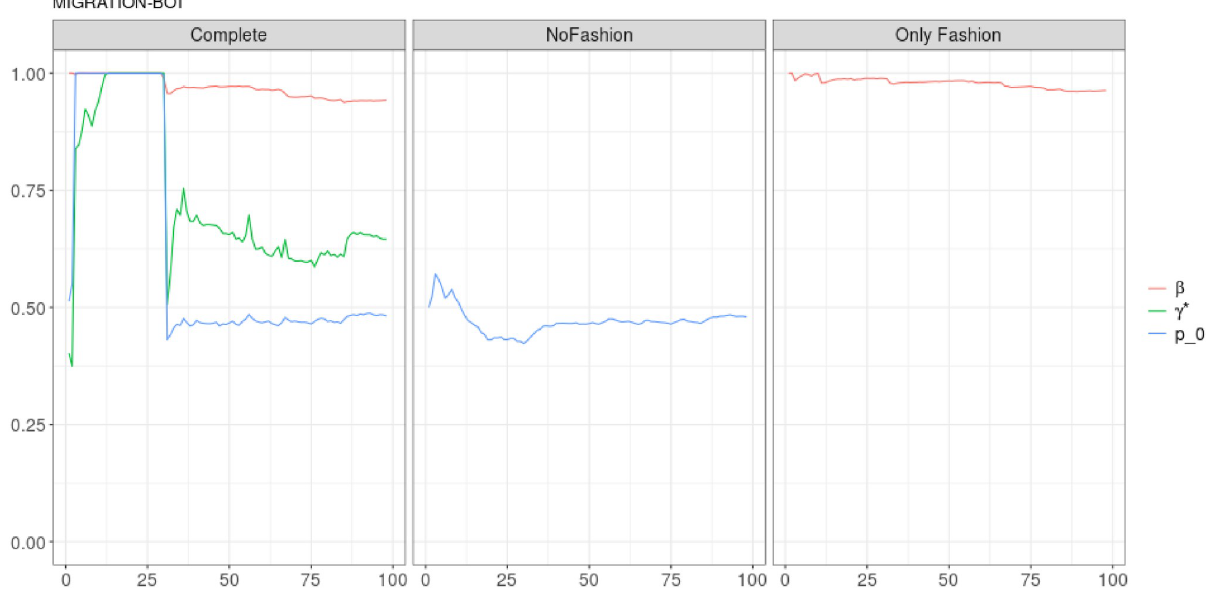
Fig 8. “Migration” ( T = 0.35, only BOTs’ posts, D = 3 0 ): Model parameters evolution with S = 100 slots of equal size (i.e. 41 observations). In the left panel, it is possible to distinguish an “Only fashion” initial phase ( γ � ’ 1) and more balanced phase ( γ � 2 [0.5, 0.75]).